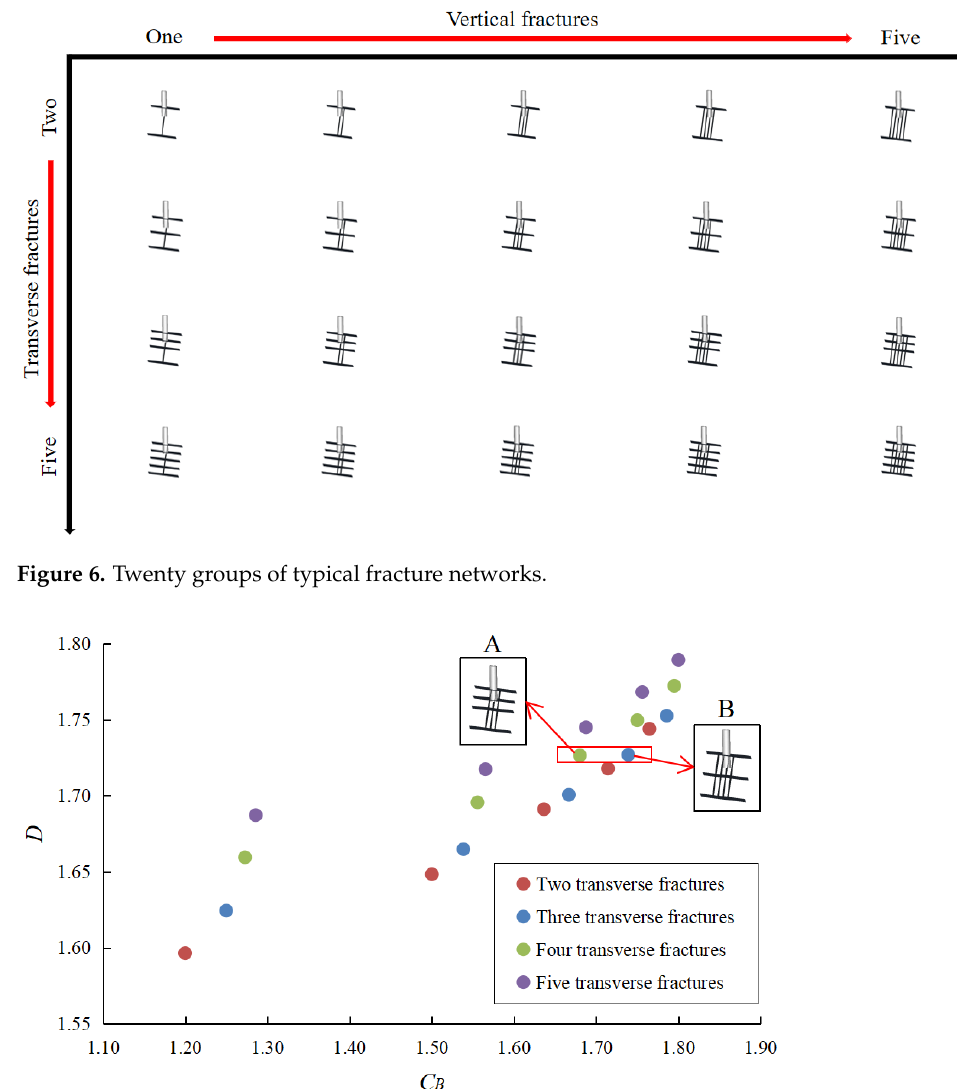
Figure 7. Relationship between the average number of connections per branch ( C B ) and the fractal dimension ( D ) of typical fracture networks.